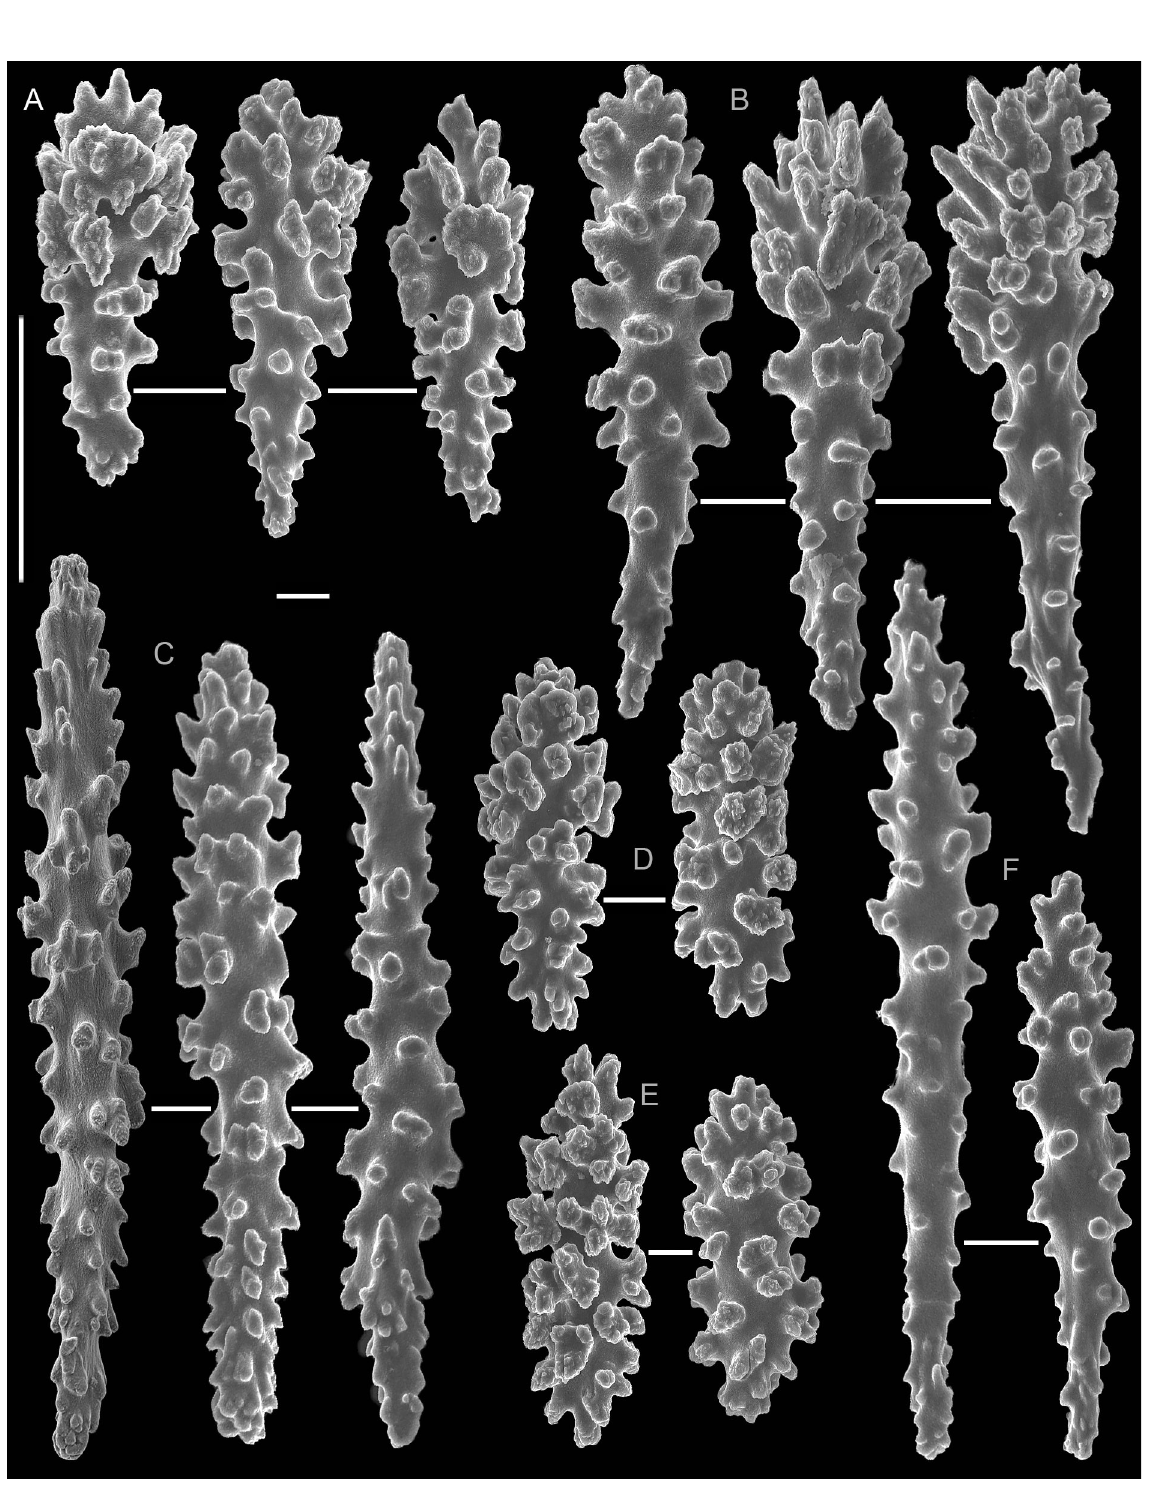
Fig. 8. Calcigorgia simushiri sp. nov., holotype (MIMB 20721), sclerites from the upper part of the body wall of polyp. A . Short warty clubs. B . Longer clubs with curved handles. C . Spindles. D . Ovals. E . Capstans ornamented with girdled warts. F . Club-like spindles. Scale bar: 0.1